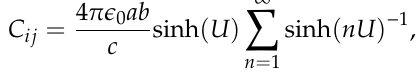
Figure 2. Equivalent circuit of 2D arrays of palladium nano-islands.